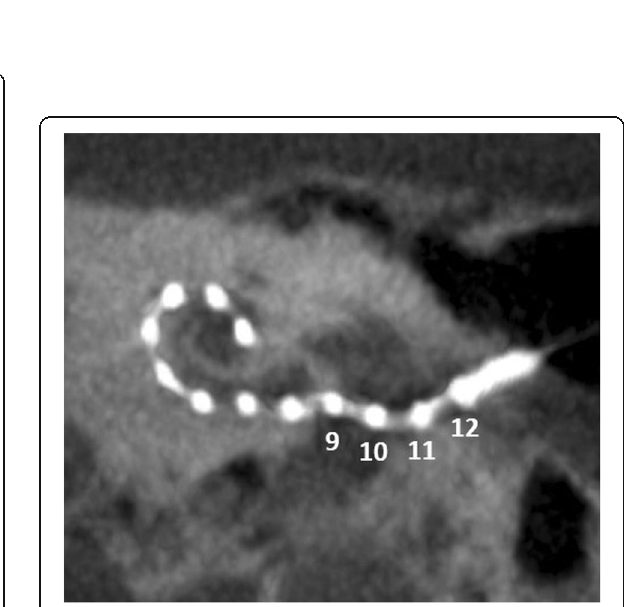
Fig. 26 A 11-year-old male patient, with overinserted electrode. CBCT paraaxial maximum intensity projection image shows the most basal electrode contact 7 mm from the round window (arrowhead)